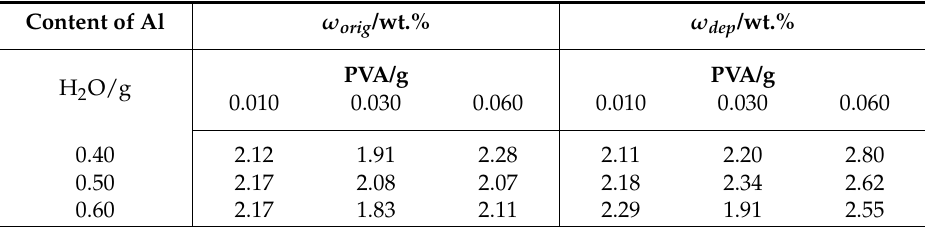
Table 3. Al contents (wt.%) of the samples before and after spraying tests ( − 30 kV). Content of Al ω orig /wt.% ω dep /wt.% PVA/g H 2 O/g